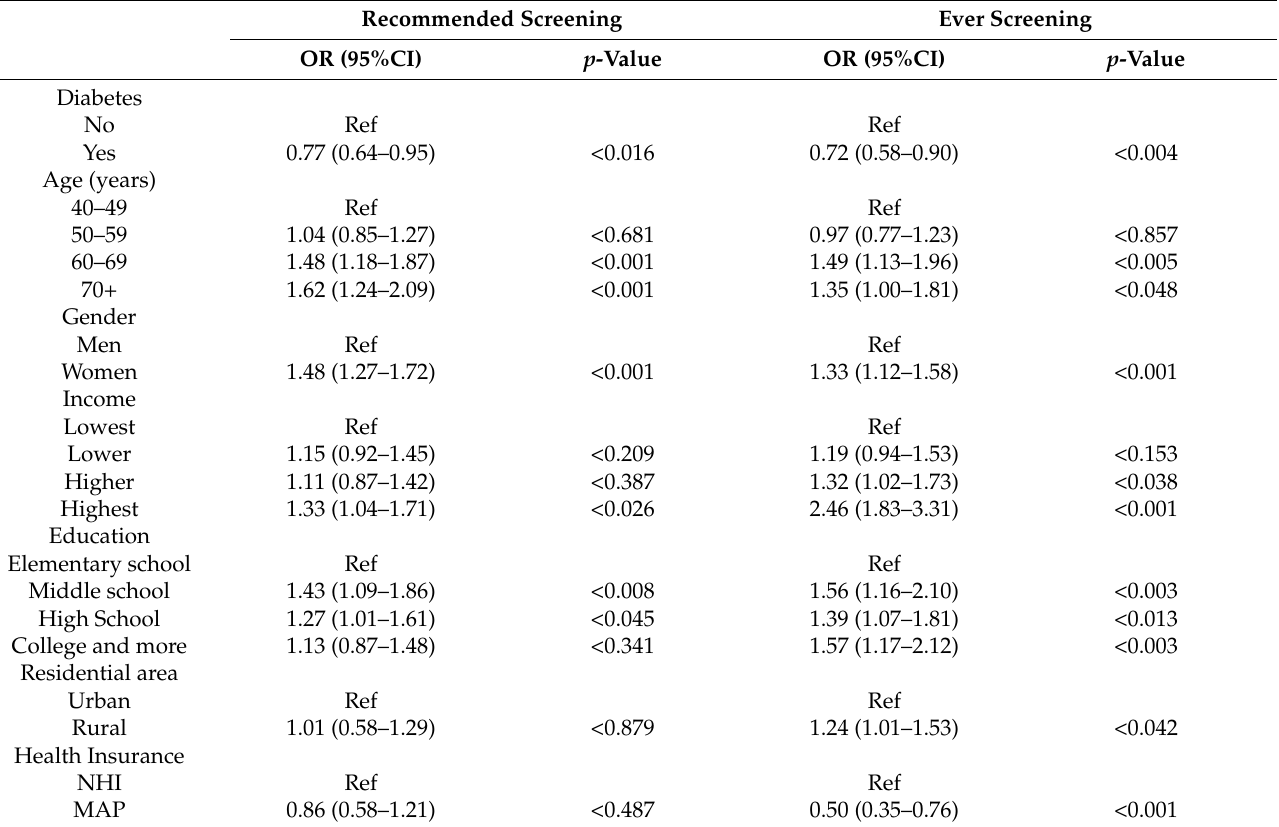
Table 3. Multivariable logistic regression analysis of the diabetes status and socio-demographic factors. Recommended Screening Ever